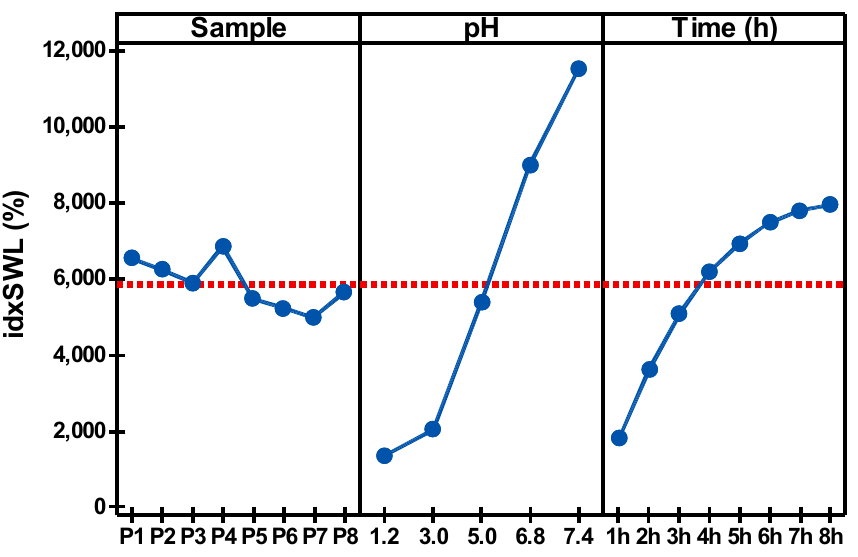
Figure 8. Main effects plot of the three factors (Sample, pH and Time) based on three-way ANOVA ( p = 0.05) for the microsphere swelling index (idxSWL (%)).